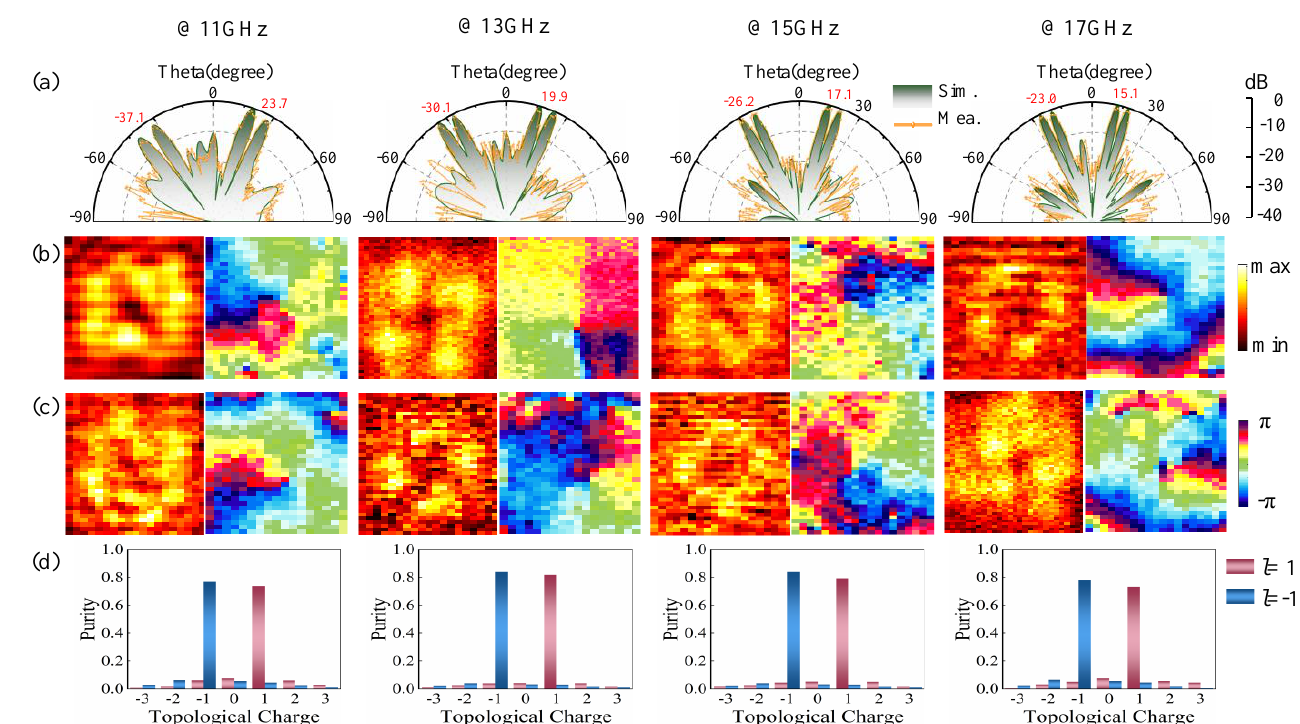
Figure 7. Experimental results at different frequencies. ( a ) Far-field normalized 1D scattering pattern at a φ = 315° plane. Near-field amplitude and phase of vortex wave with OAM mode ( b ) l = 1 in fourth quadrant space and ( c ) l = − 1 in second quadrant space. ( d ) The purity of the OAM mode with different topological